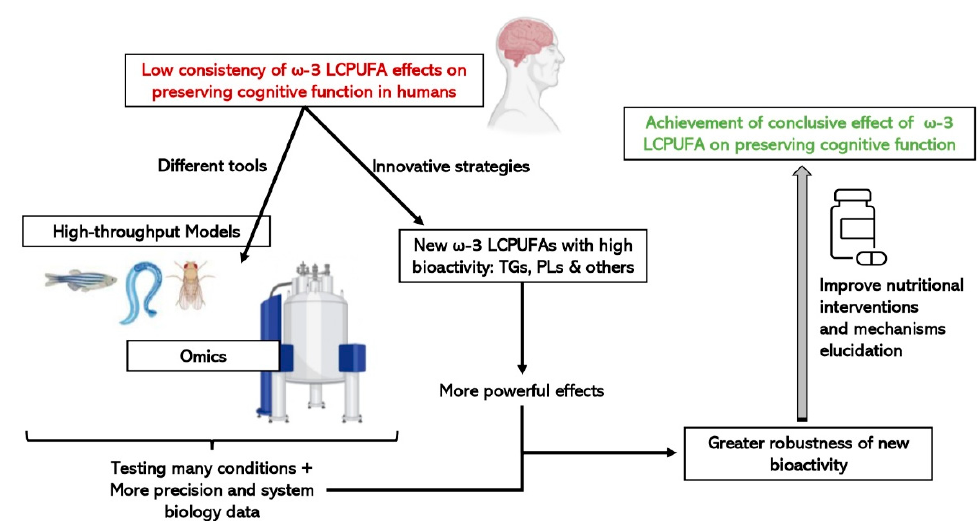
Figure 3. Advantages of integrating the use of omic technologies and small high-throughput in vivo models on the study of the efficacy of new structures of ω -3 LCPUFAs on cognitive function.